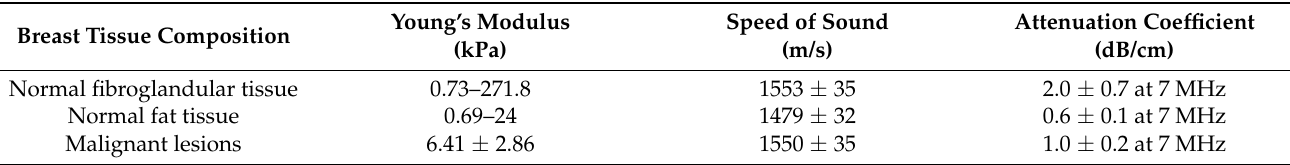
Table 2. Mechanical and acoustic properties for fat tissue, glandular tissue and tumor from literature review [9]. Breast Tissue